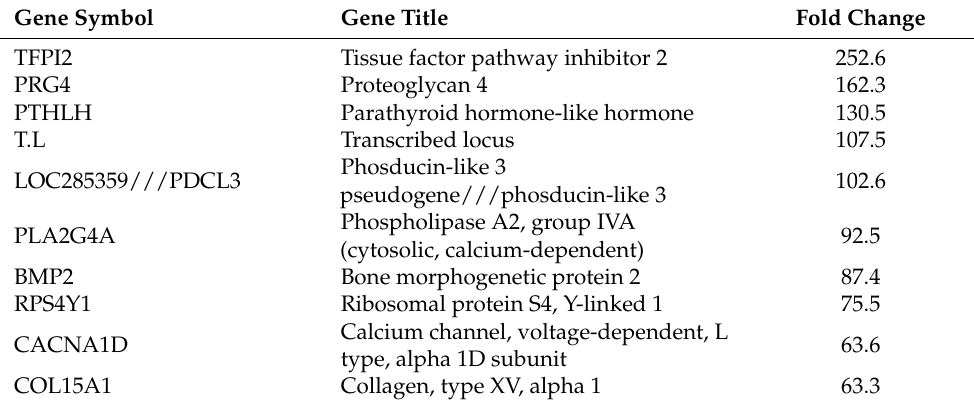
Figure 8. Scheme for species-specific gene expression analysis. We injected 1 × 10 6 human synovial MSCs into the knees of rats 7 days after ACL transection. One day later, we harvested rat synovium and prepared total RNA for microarrays and RT-PCR. We also prepared total RNA from a mixture of harvested, un-injected control rat synovium, and 1 × 10 4 human synovial MSCs as a control (reproduced from [21]). Table 1. The top 10 human transcripts upregulated in the human MSCs that migrated within the synovium. Gene Symbol